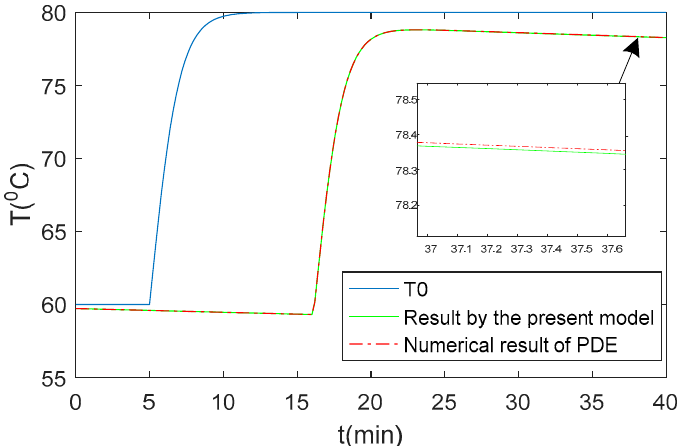
Figure 3. Results with step function.